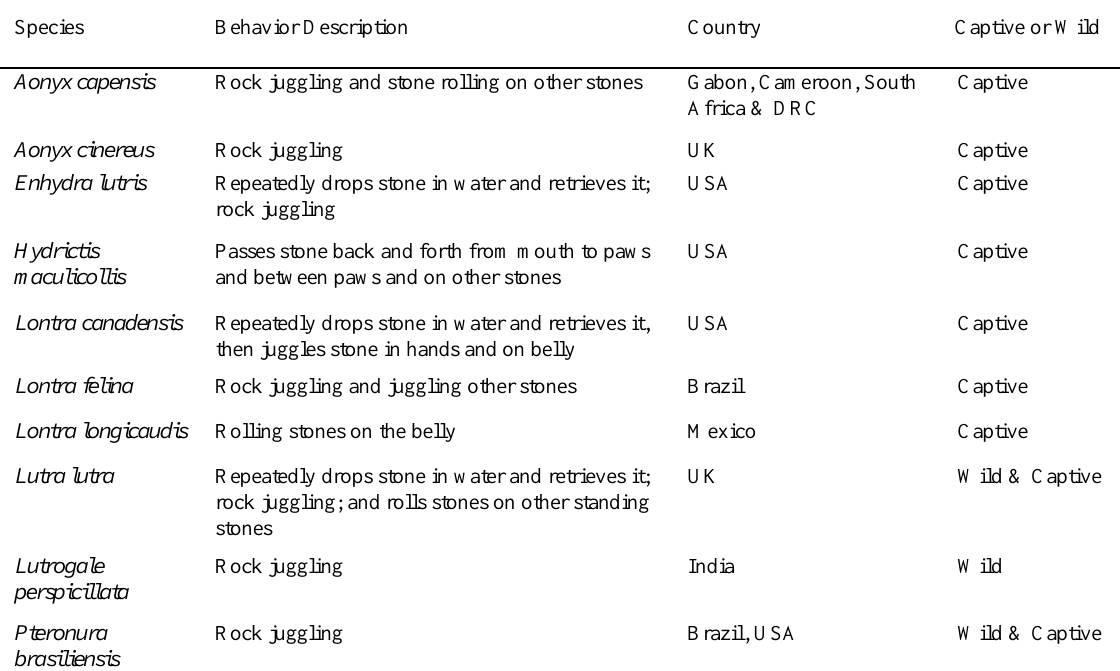
Observations of SH Behavior Across Wild and Captive